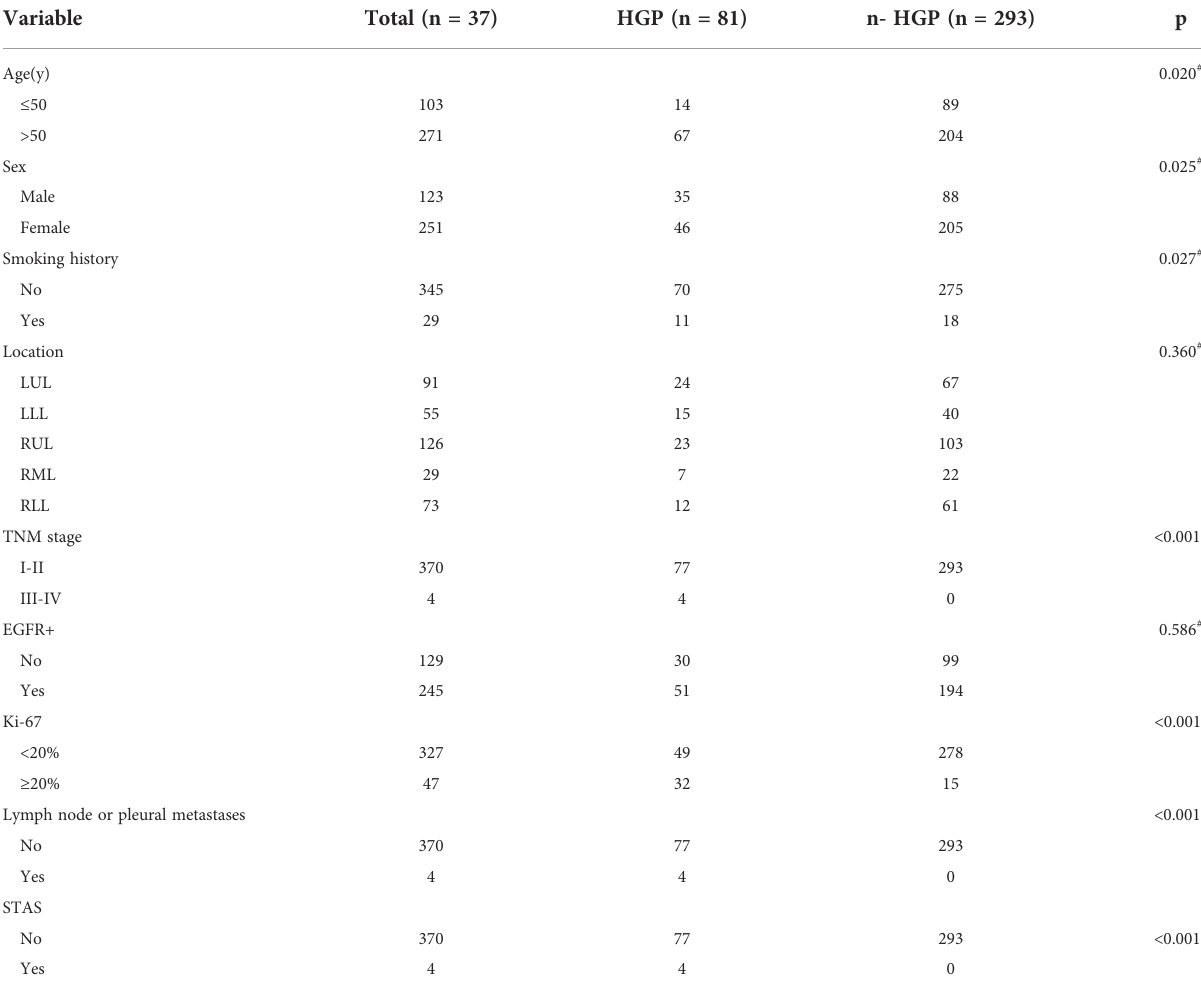
TABLE 2 Clinical and pathological